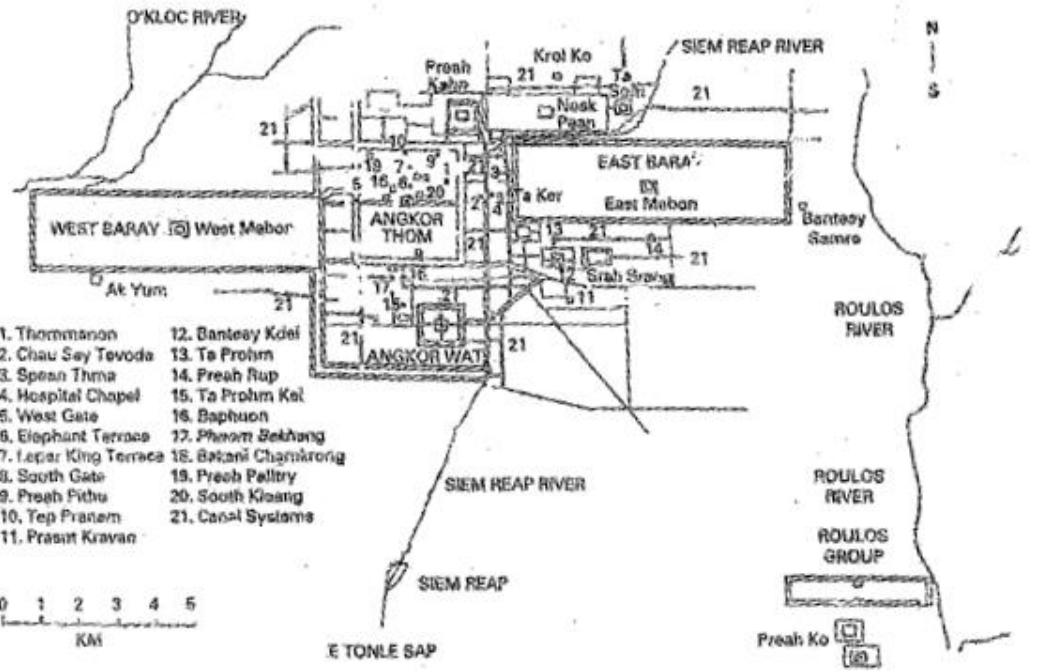
Figure 17. Plan view of urban Angkor and surroundings showing East and West Barays. Site names in Appendix A.2. Figure from [1], p. 359.